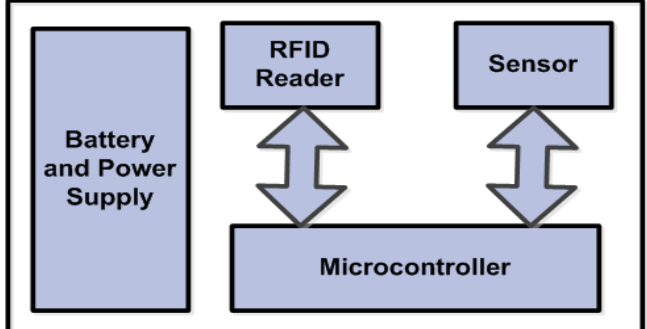
Figure 3. General block diagram of sensor